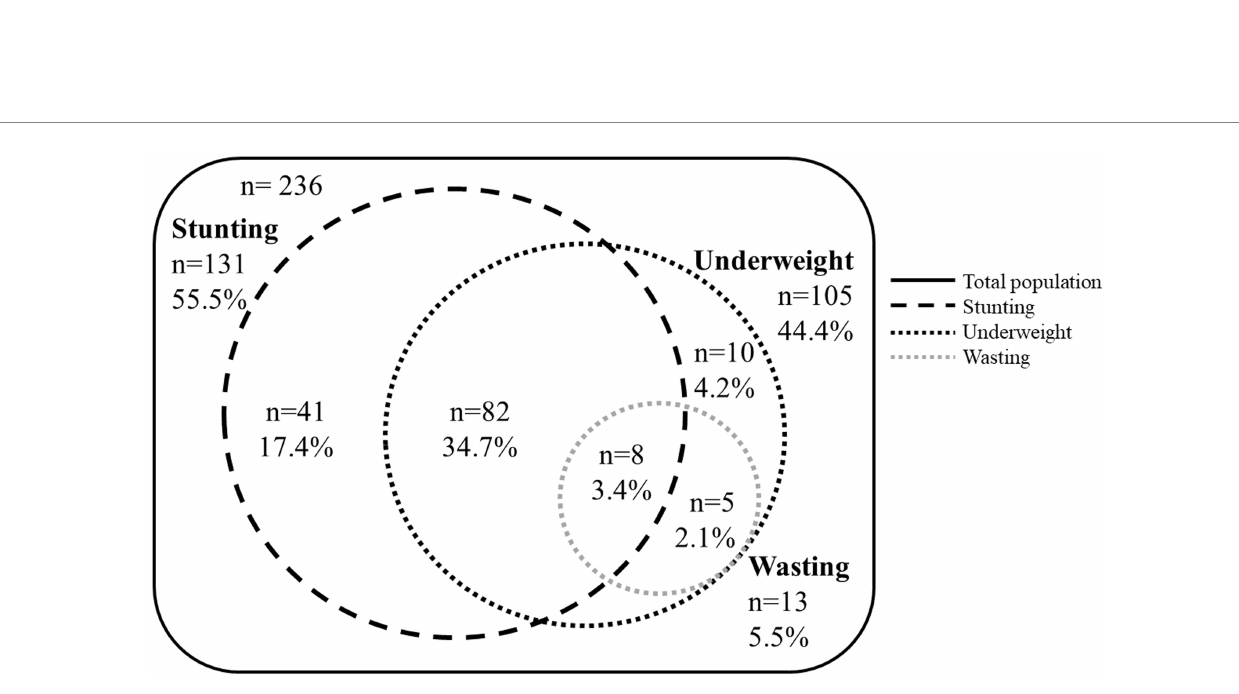
FIGURE 4 Venn diagram showing overlapping proportions of stunting, underweight, and wasting in children 54–66 months from